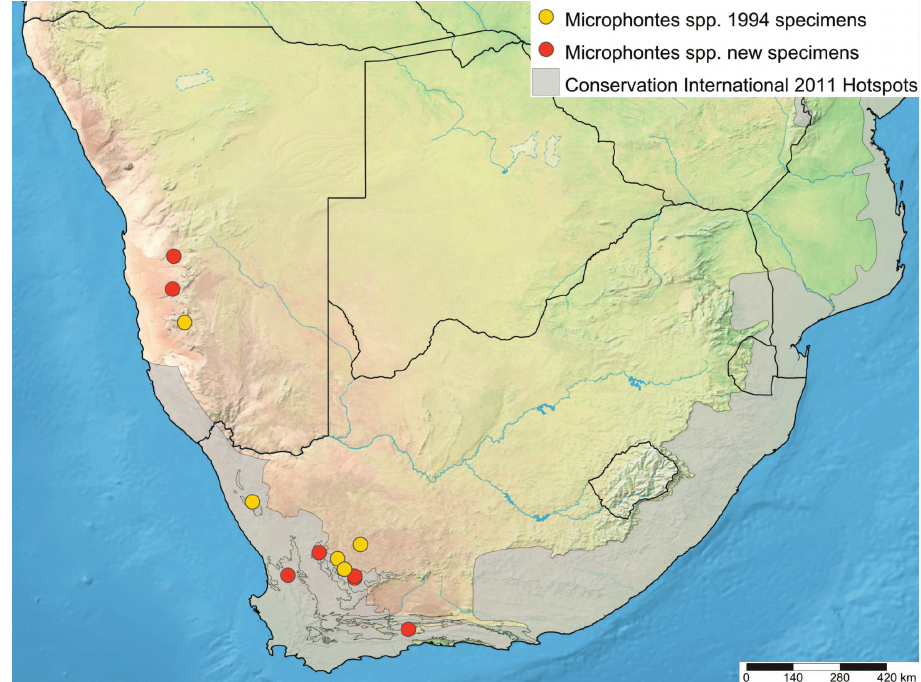
Figure 5. Map of Southern Africa with elevational relief, Biodiversity Hotspots ( sensu Conservation In- ternational) and distribution of Microphontes specimens studied in 1994 and now (SimpleMappr 10597). Map data available in Google Earth KML file 10597 and also through GBIF (data-set http://www.gbif. org/dataset/4c13483d-a2ac-4c61-9087-c4e1a3c7b91d, DOI